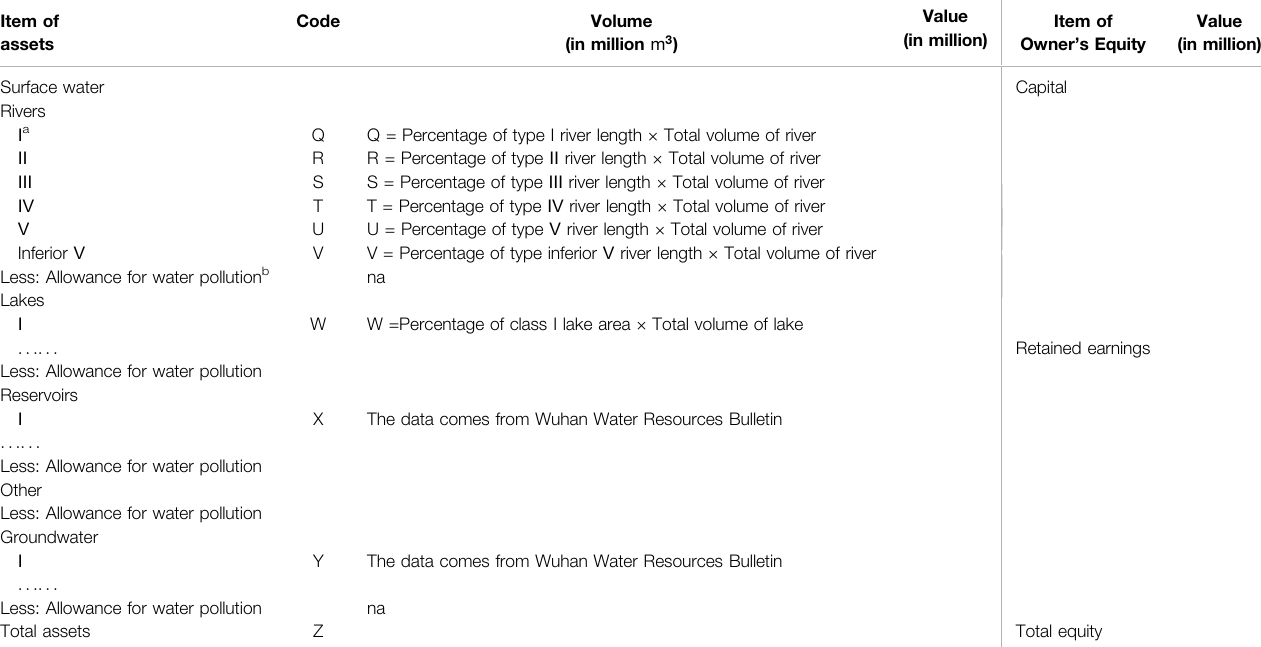
TABLE 3 | Regional water resource balance